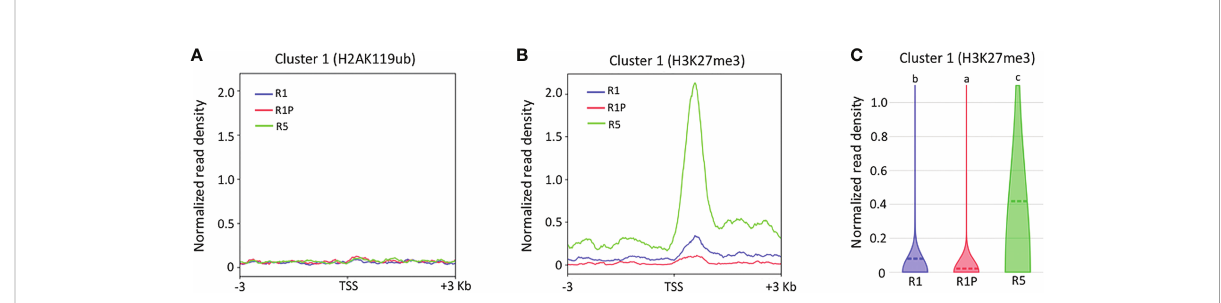
FIGURE 4 Differences in histone marks of genes belonging to clusters 1 among R1, R1P and R5. TSS enrichment scores from ChIP-Seq of H2AK119ub (A) and H3K27me3 (B) were plotted at ±3 Kb of the transcription start site (TSS) of genes belonging to cluster 1. (C) Violin plots showing normalized